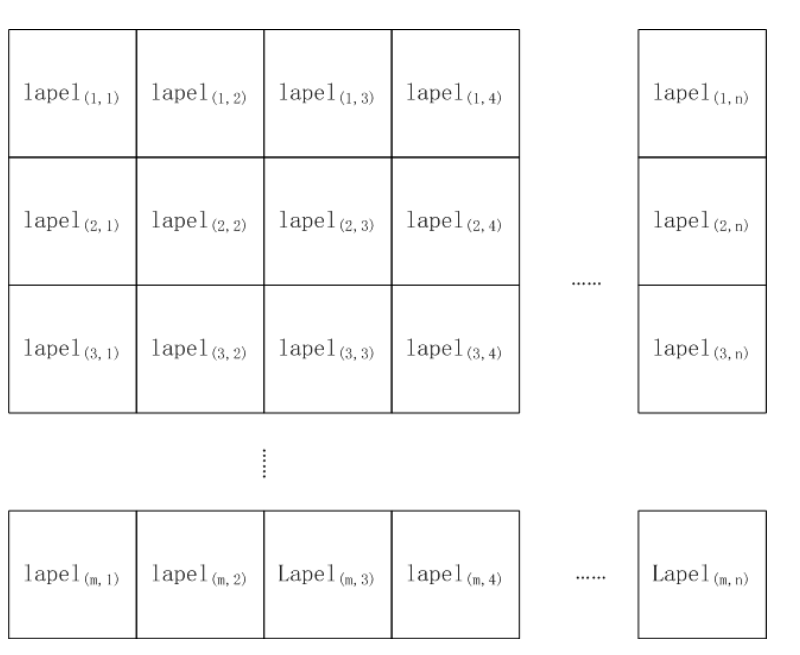
Figure 14. The lapel point matrix of the dataset. The size of the matrix is related to the DEM area and skyline sampling density. The element ( i , j ) in the matrix represents the number of lapel points on the skyline ( i , j )